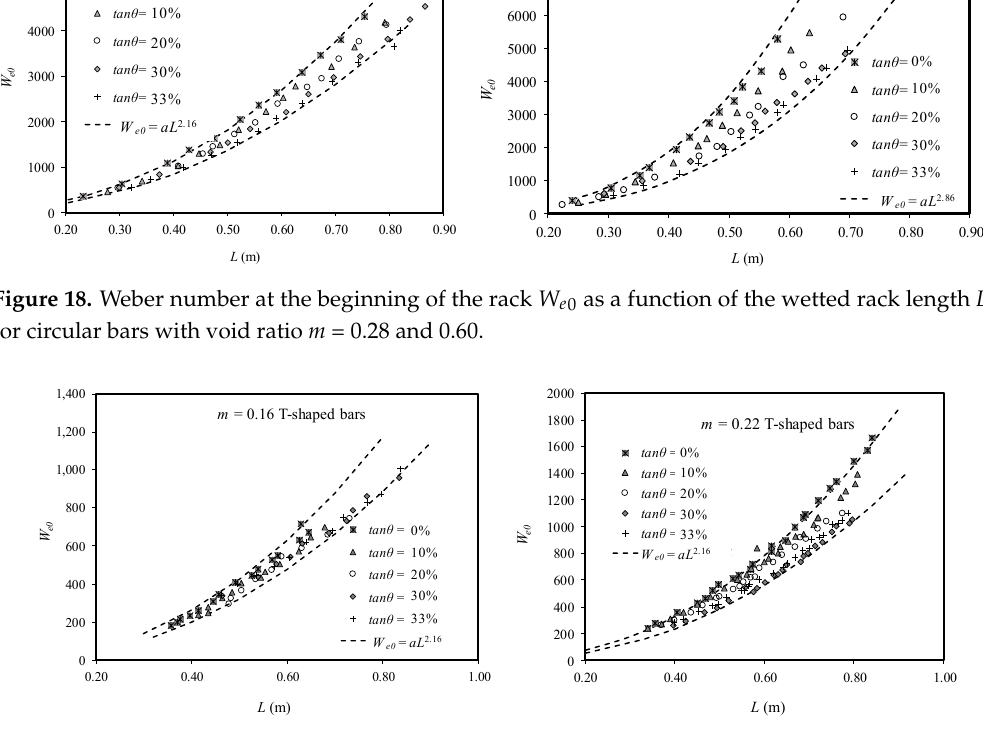
Figure 19. Weber number at the beginning of the rack W e0 as a function of the wetted rack length L , for T-shaped flat bars with void ratio m = 0.16 and 0.22.